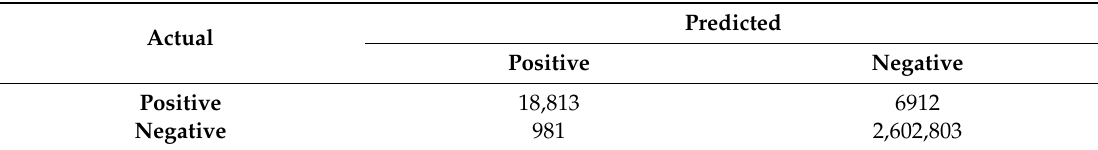
Table 2. Confusion matrix for the NDWI.